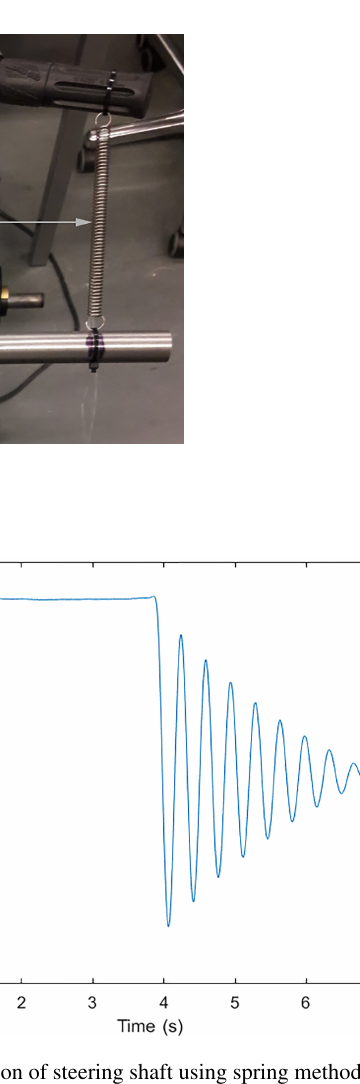
Figure 12. Oscillation of steering shaft using spring